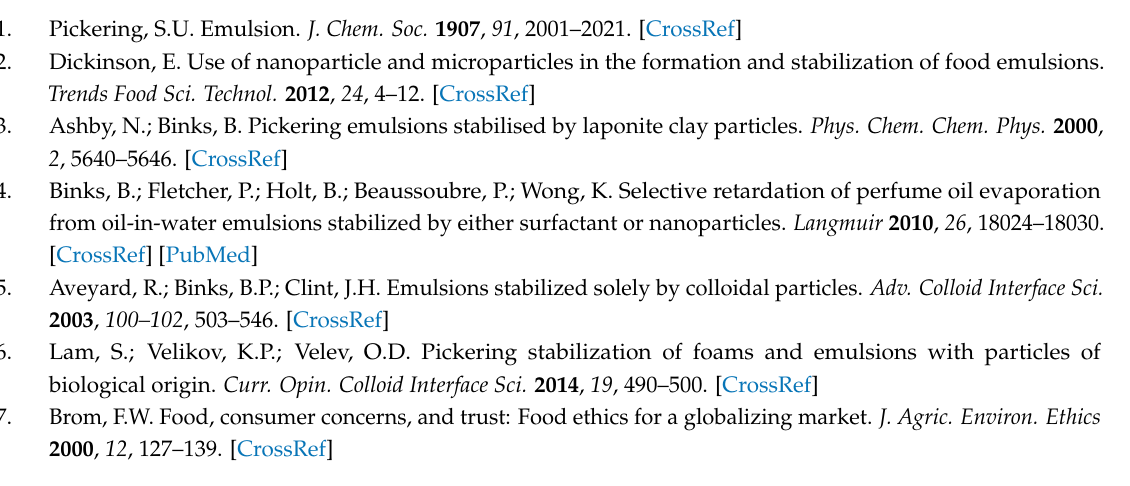
Figure S1: Confocal Laser Scanning Micrographs of limonene/corn oil-in-water emulsions stabilized by Blg microgels after 3 weeks of storage, Figure S2: Dynamic volumetric changes in pendant droplets during release of 1-hexanol in MG 57 suspensions in terms of (A) volume of the pendant droplet or (B) volume loss of pendant droplet normalized by the droplet interfacial area and the total volume loss at long